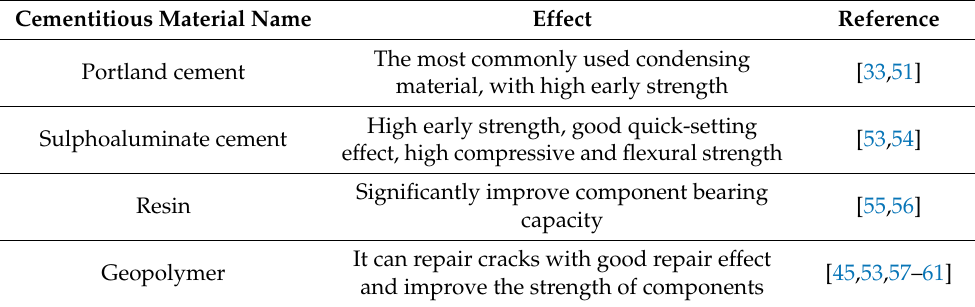
Table 2. The effect of different cementitious materials on components.